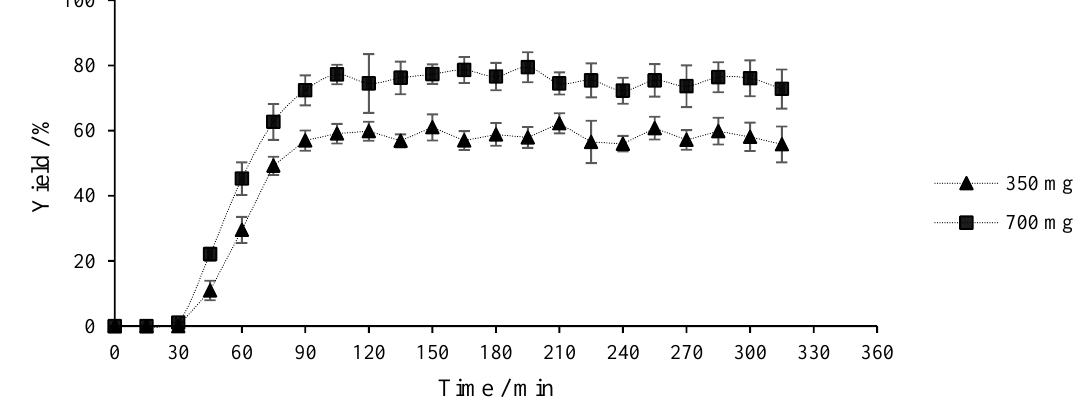
Figure 13. Yield over time for continuous flow process using 350 mg and 700 mg of freeze-dried cells hosting DERA; 32.5 °C, 0.1 M of TEOA buffer, pH 7.5, 0.1 mL/min flow rate, 0.25 M of 2 , 0.5 M of 1 .